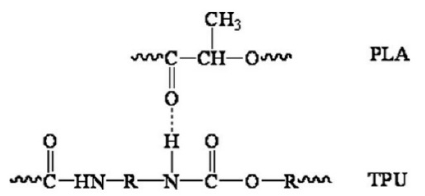
Figure 5. Schematic diagram of hydrogen bonding between the molecules of PLA and TPU. Re- produced with permission from Feng and Ye, Journal of Applied Polymer Science; published by John Wiley and Sons, 2011. [69].